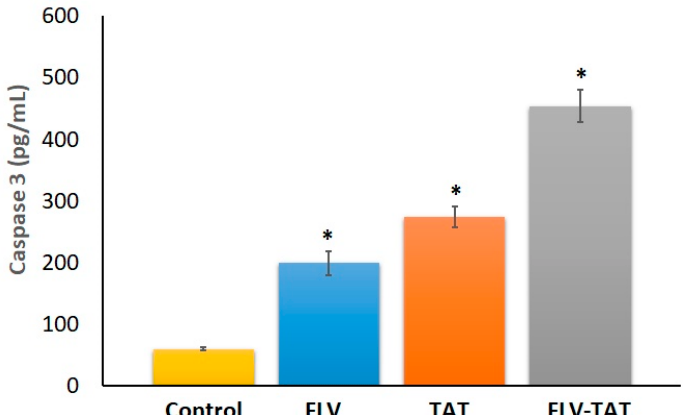
Figure 7. Impact of FLV, TAT, and optimized FLV–TAT on caspase 3 enzyme concentrations in HepG2 cells. All incubation continued for 48 h. Data represent mean of six independent replicates ± SD. * Significantly different ( p < 0.05) relative to the corresponding control.